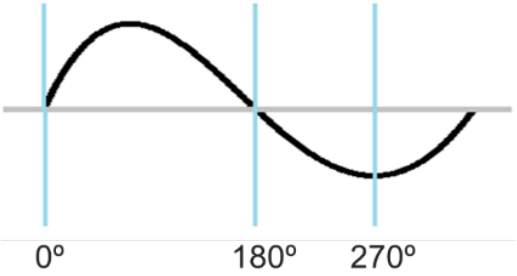
Figure 3. The phase of a waveform measured in degrees between 0 ° and 360 °.